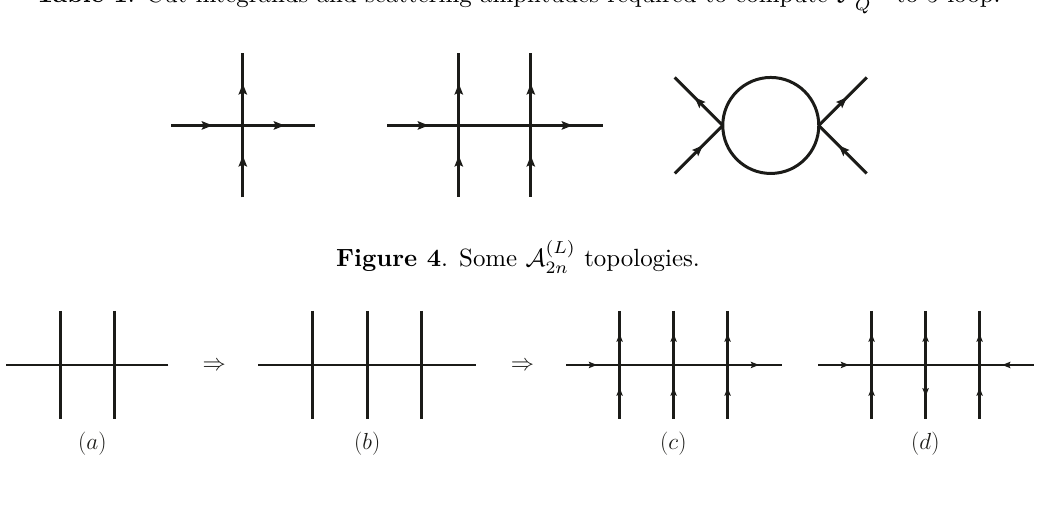
Figure 5 . (a): the 6-point φ 4 topology. (b): the 8-point φ 4 topology. (c) and (d): the topologies contributing to A (0) 8